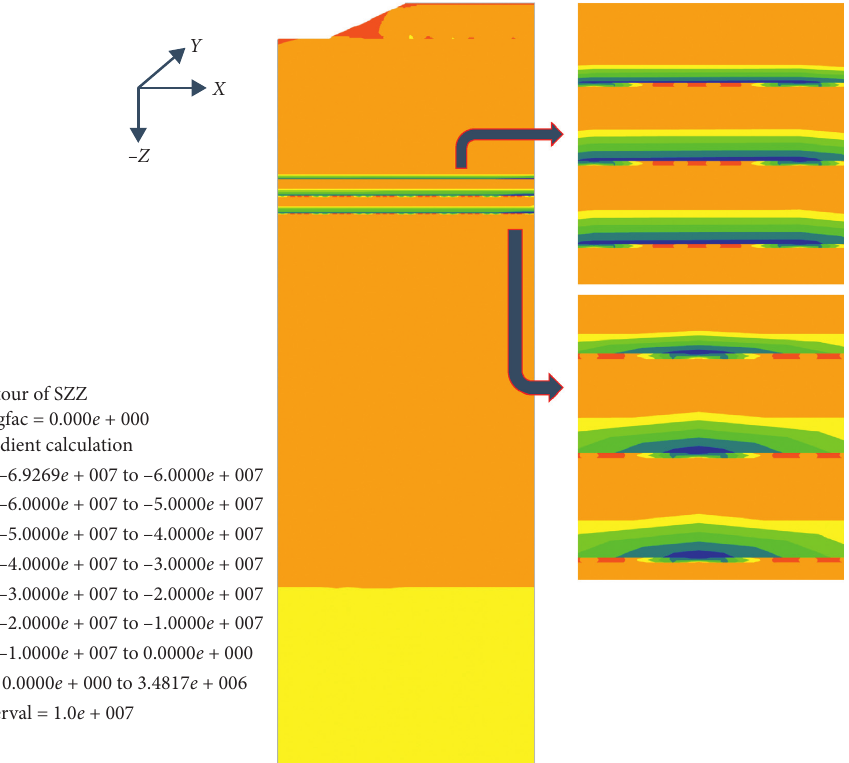
Figure 6: Cloud chart of vertical stress for the model after fracturing.